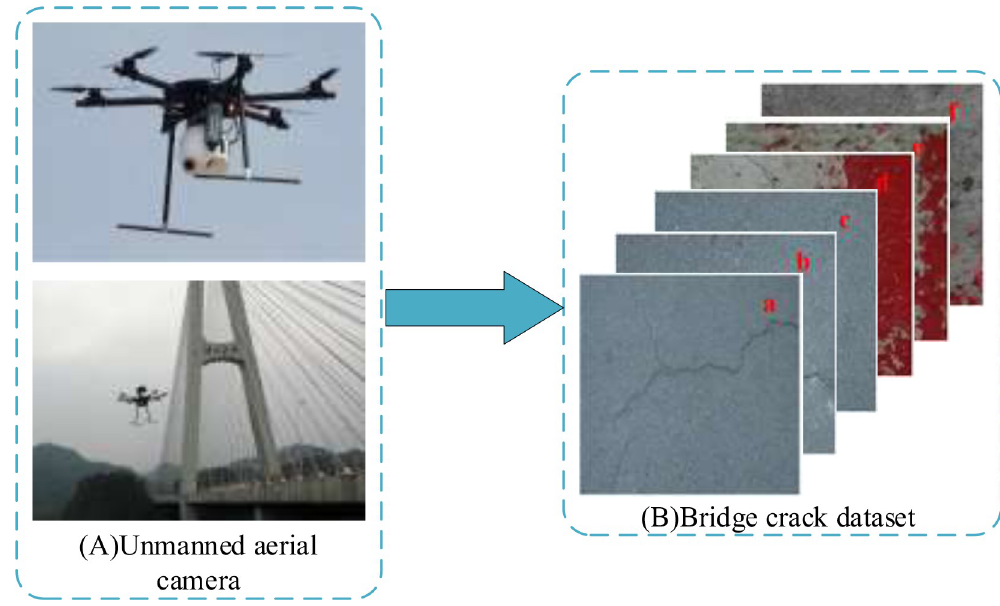
Fig 1. Crack collection